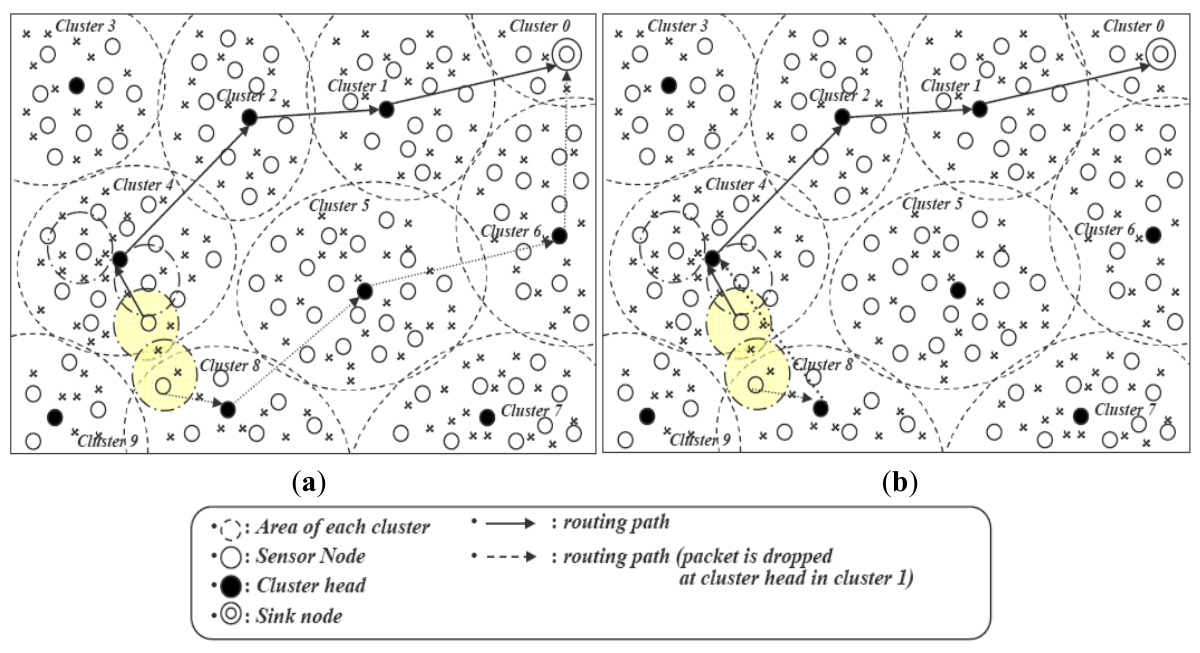
Figure 6. Inter-cluster duplicate detection and elimination: ( a ) Duplicate data elimination